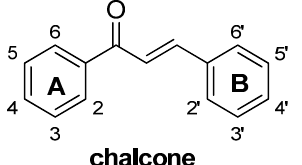
Figure 1. General structure of